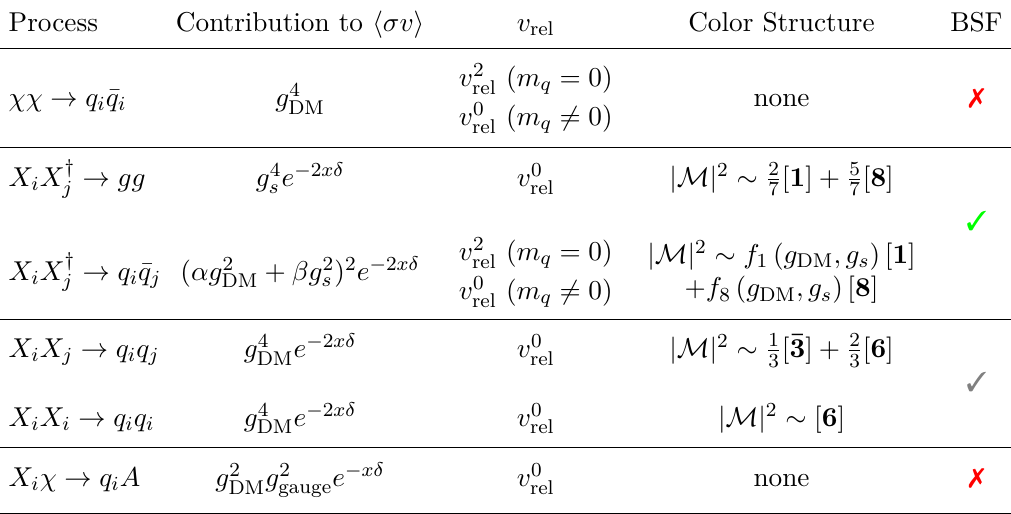
Table 1. Summary of the most relevant processes contributing to the (co-)annihilation of DM (the corresponding Feynman diagrams are depicted in figure 1). In the second column, we present the coupling structure combined with the suppression factor caused by the mass splitting δ in the dark sector. Here, g generically represent the gauge coupling in the vertex q ¯ qA , with A being gauge the involved gauge boson (these are g , γ , Z , and W ± , although the latter applies only to the q L model). In the XX † → q ¯ q process, α and β generically indicate the contribution from the Yukawa- and the gluon-mediated process. The third column shows the dominant velocity dependence of σv rel in the limit of low relative velocities. A distinction between massive and massless quark is also highlighted, with the latter being the most relevant case for our analysis. The fourth column gives the decomposition of the squared matrix element into the individual contributions of different color configurations [ ˆ R ] , with f and f being some functions of the coupling constants. The fifth 1 8 column indicates the ability of the initial-state particles to form ( 3 ) or not to form ( 7 ) a bound state and a 3 corresponds to the suppressed BSF when these are not in conjugate